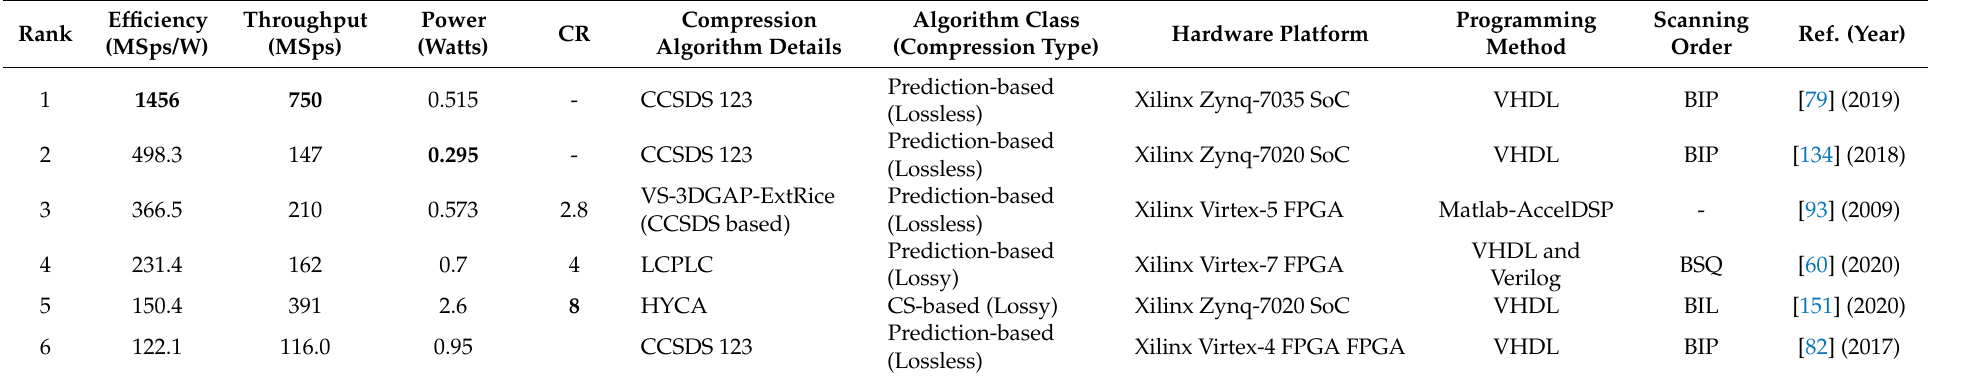
Table 17. Ranking of the best six hardware-accelerated compression algorithms for HSI in terms of their